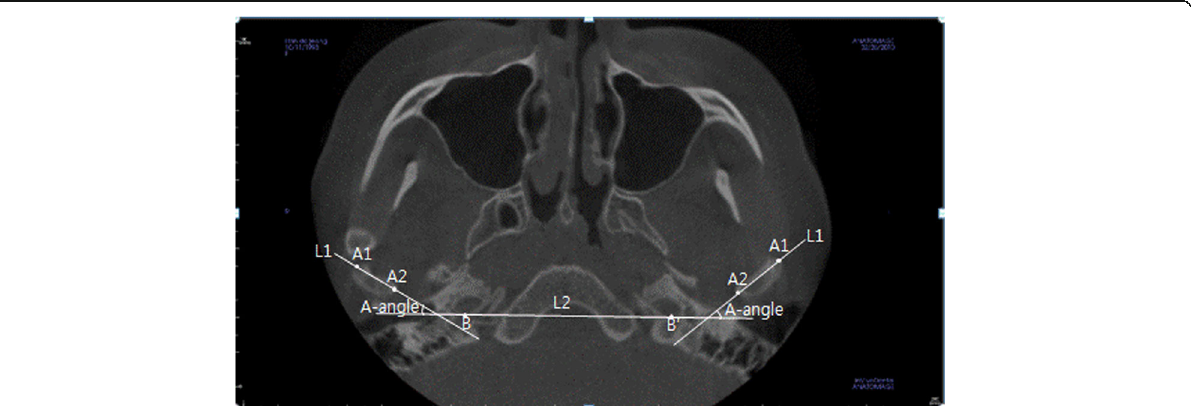
Fig. 1 Reference points and measurement of axial view in CBCT. A1 outer pole of condylar head, A2 inner pole of condylar head, B,B ′ hindmost point of the carotid canal, L1 line passing A1 and A2, L2 line passing B and B ′ , A-angle angle between L1 and L2